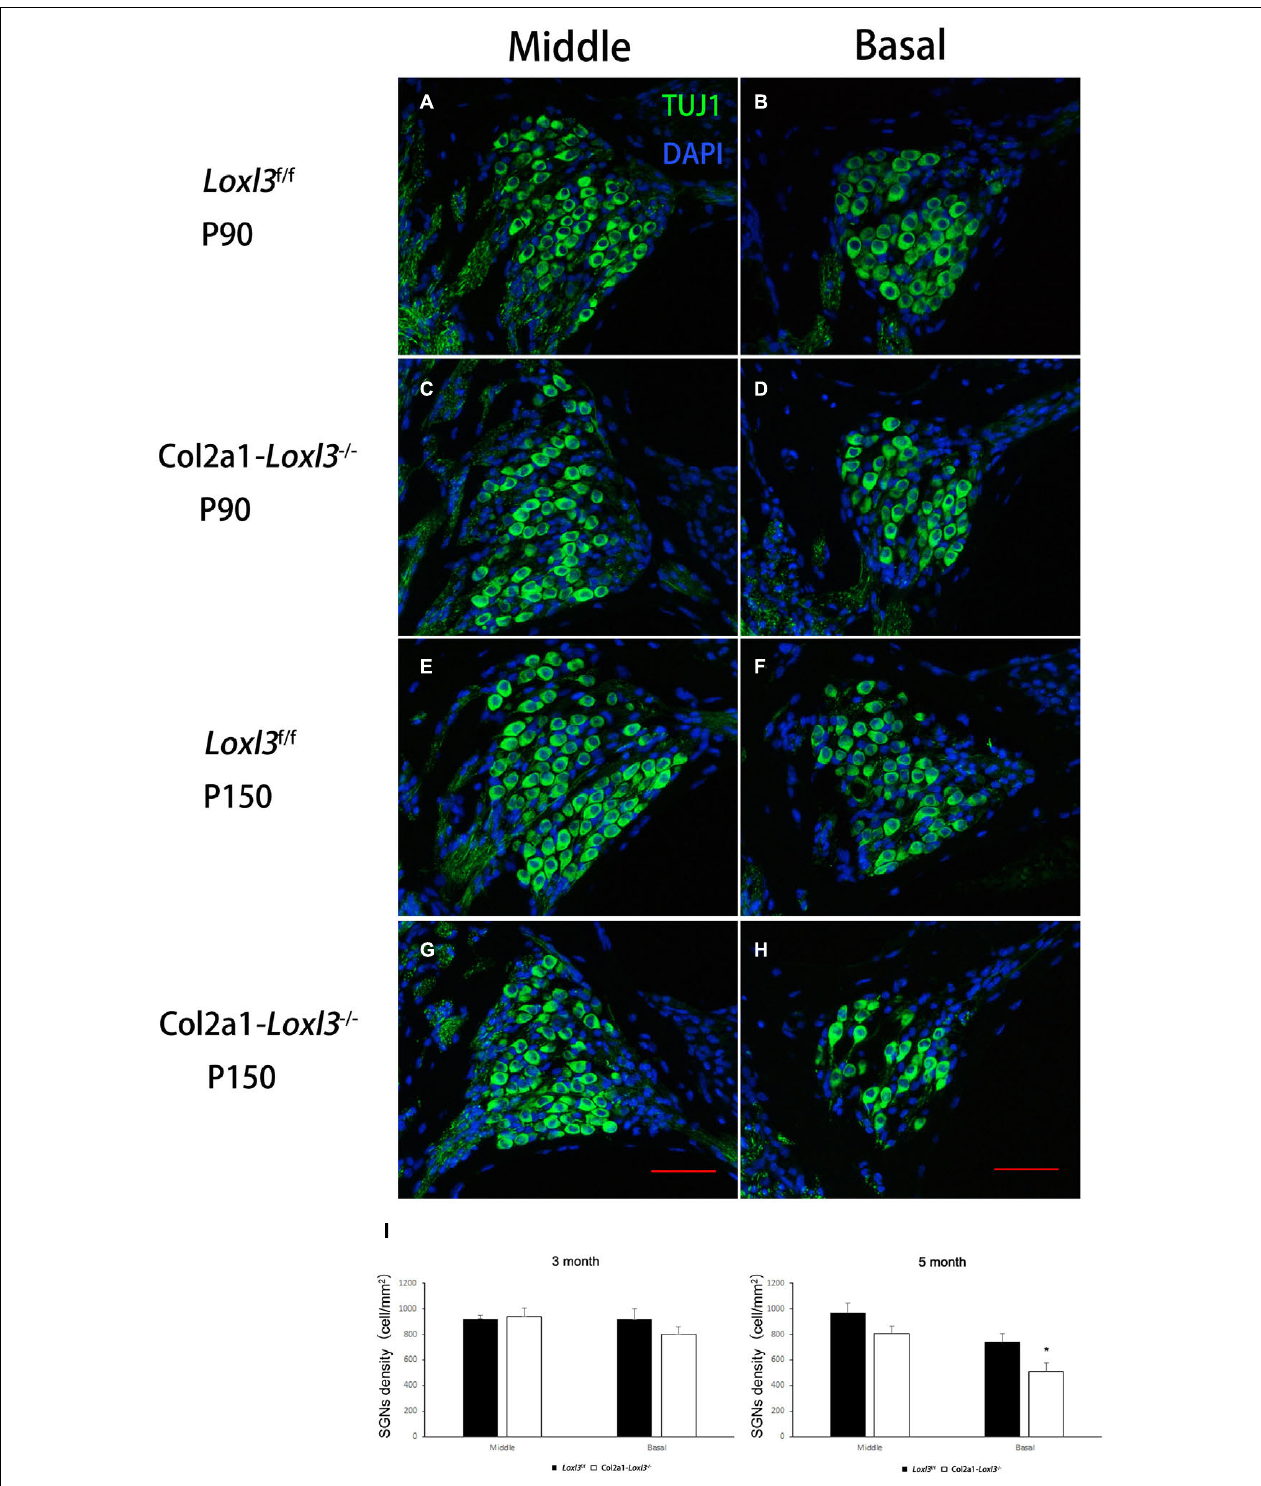
FIGURE 6 | Images of SGNs in Loxl3 f / f and Col2a1–Loxl3 − / − mice. (A–D) Representative image of Tuj1 (green) immunofluorescence in the spiral ganglion cells of Loxl3 f / f and Col2a1–Loxl3 − / − mice at P90. Tuj1 is a marker of types I and II neurons; no significant difference was observed between the Col2a1–Loxl3 − / − and Loxl3 f / f mice. (E–H) Representative image of Tuj1 (green) immunofluorescence in the spiral ganglion cells of Loxl3 f / f and Col2a1–Loxl3 − / − mice at P150. Scale bars: 100 µ m. (I) Counting of the SGNs in the serial sections showed a significant decrease in the density of the SGNs in Col2a1–Loxl3 − / − mice at P150 ( n = 5). * p < 0.05 by two-tailed Student’s t test.